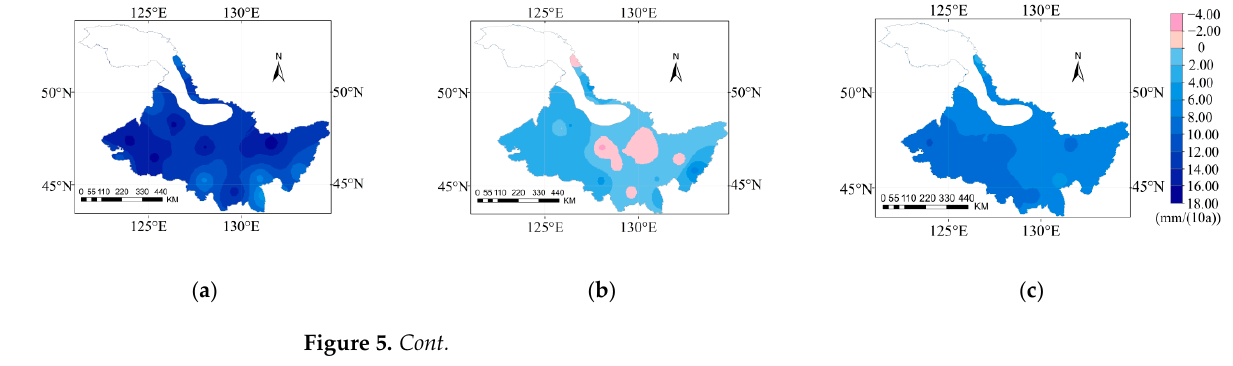
Figure 4. Spatial distribution of reference crop evapotranspiration ( ET 0 ) during the ( a ) 2030s, ( b ) 2050s, and ( c ) 2070s under RCP4.5, and during the ( d ) 2030s, ( e ) 2050s, and ( f ) 2070s under RCP8.5 during the soybean growth period.